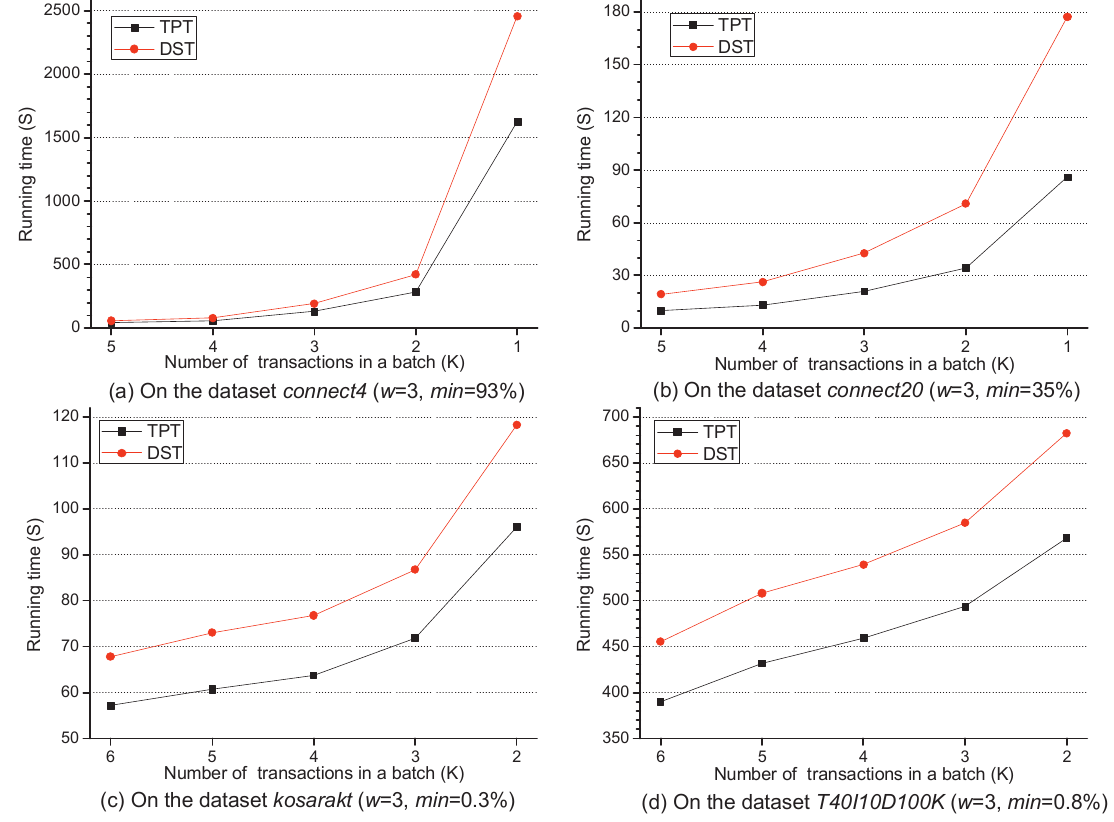
Fig. 9. Evaluation on varied